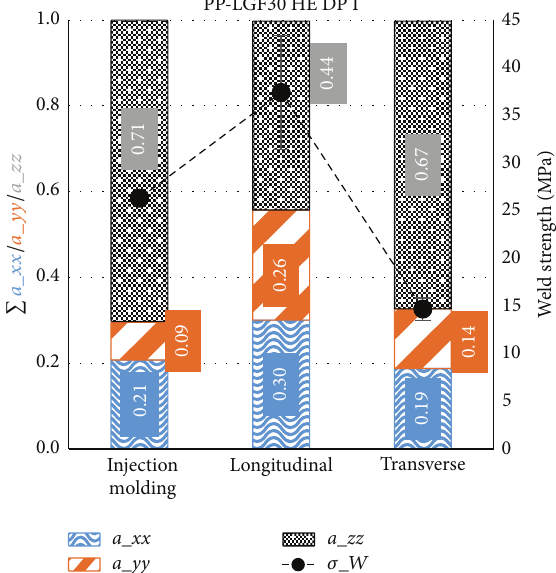
Figure 20: Fiber orientation and weld strength in hot plate welding of PP-LGF30 for different initial fiber orientations.